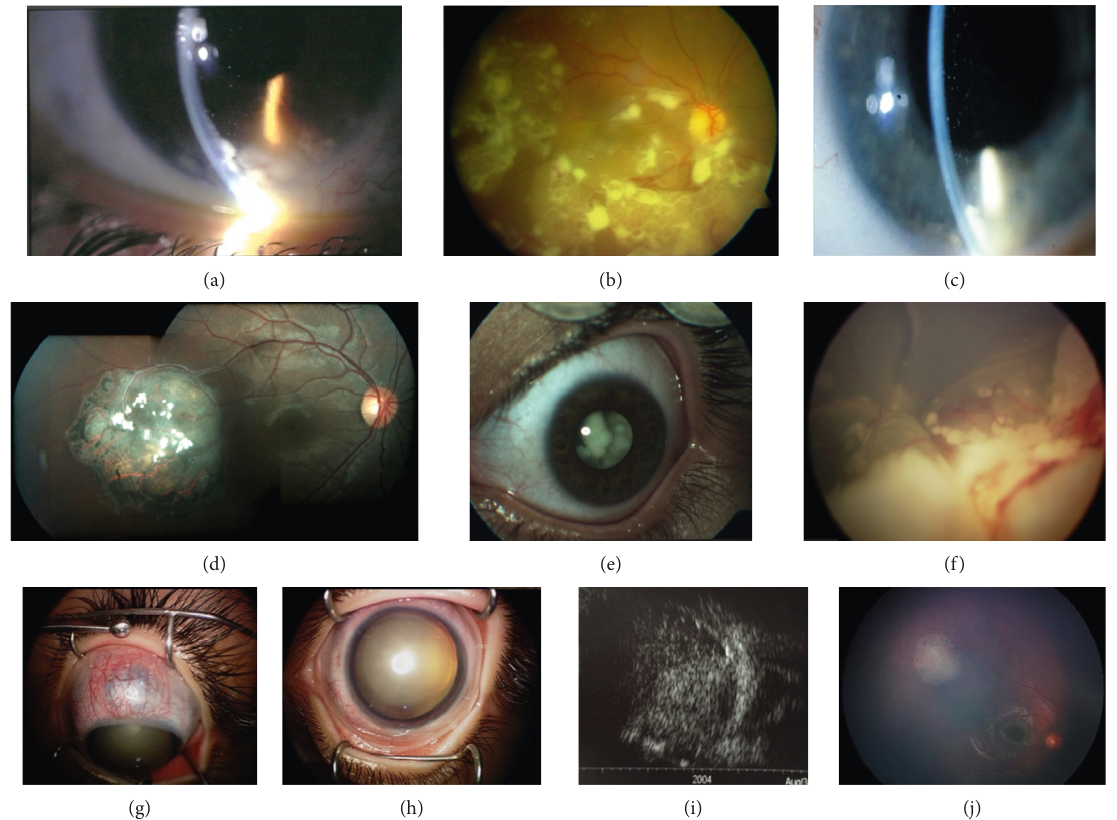
Figure 1: (a) Case #1. Anterior segment photo of the right eye in a 12-year-old-male patient showing multiple, round, whitish cystic lesions (pseudocysts) in the anterior chamber. (b) Fundus photo of the same patient demonstrating similar pseudocyts over the inferior half of the retinal surface. (c) Case #7. Anterior segment photo of the left eye in a 7-year-old female patient with nonconfluent pseudocysts in the anterior chamber. (d) Case #3. A 14-year-old male patient presented with a temporally located spontaneously regressed retinoblastoma in the right eye. (e) Anterior segment photo of the same patient demonstrating group E, endophytic retinoblastoma extending just behind the lens in the left eye. (f) Case #13. Fundus photo of the left eye in a 9-year-old female patient showing mixed endophytic-exophytic retinoblastoma with vitreous seeds in the inferior half of the fundus and total retinal detachment. (g–i) Case #14. A 9-year-old male patient was referred with a presumed diagnosis of Coats’ disease in the left eye. Anterior segment photo showing rare coexistence of anterior staphyloma due to neovascular glaucoma (g), cataract, and ectropion uvea (h). Ultrasonography of the left eye demonstrating solid tumor with calcifications filling the vitreous cavity (i). (j) Fundus photo of the same patient showing a spontaneously regressed retinoblastoma located superotemporally in the fellow (right)